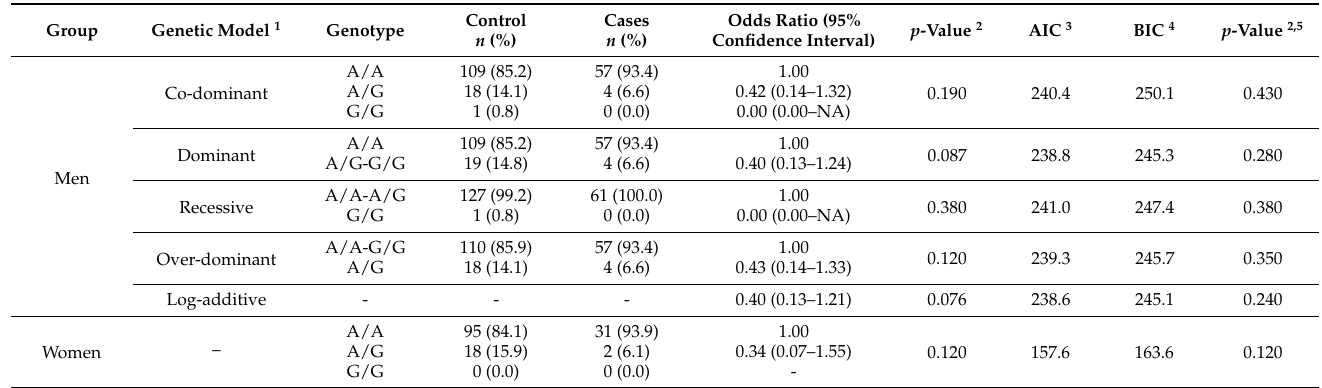
Table 3. Association analysis of rs3742330 polymorphism in DICER1 with pseudoexfoliation glau- coma cases in men and women.